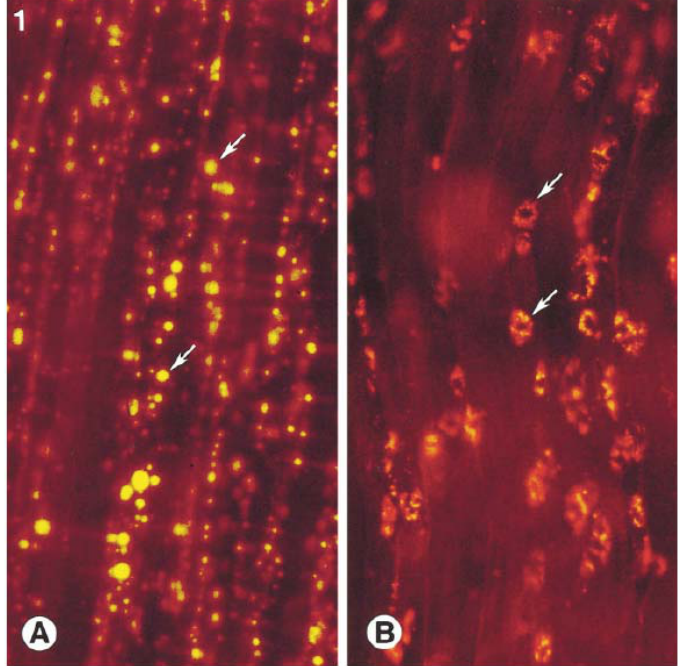
Figure 3. Fluorescently-labeled MF59 ® three hours after injection has not been taken up by cells (left). At 48 hours after injection, MF59 ® is intracellular (middle). Images taken with permission from reference